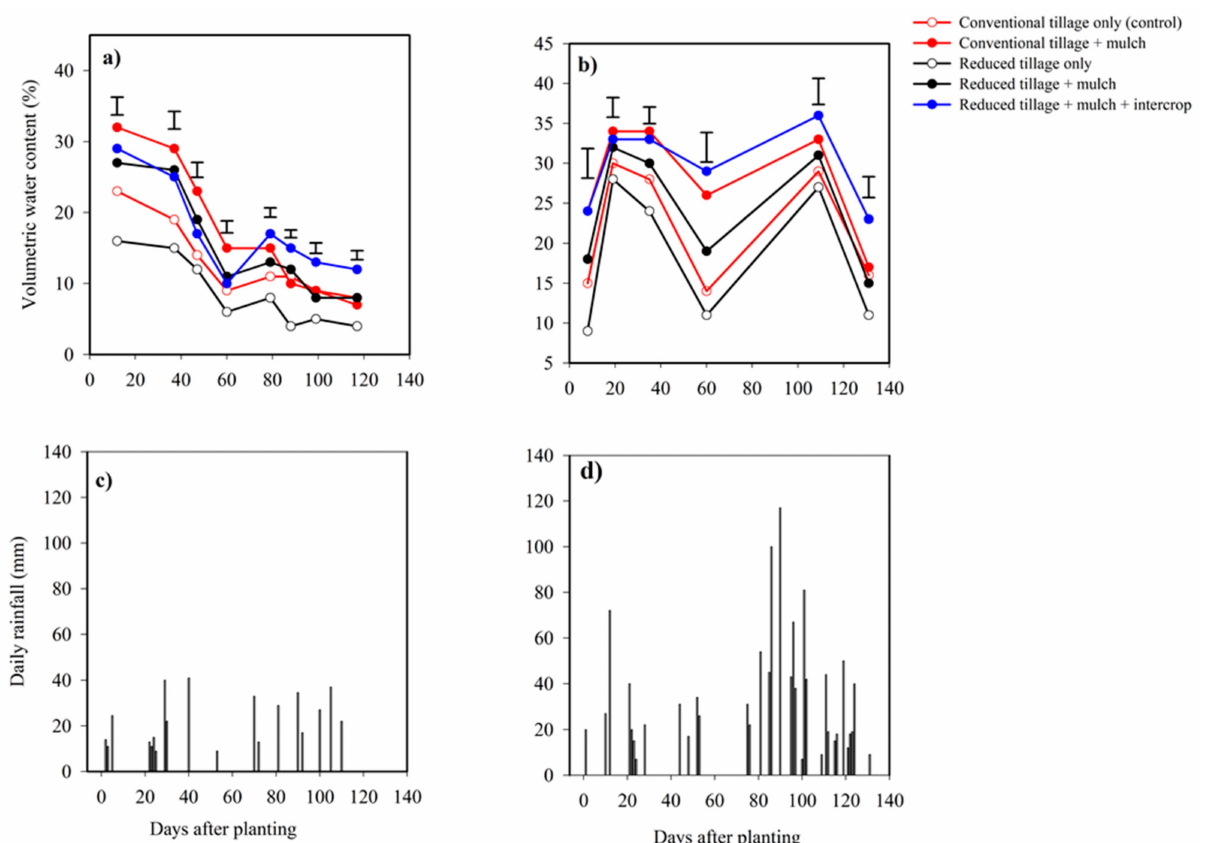
Figure 2. Volumetric water content (0–45 cm) ( a , b ) and daily in-crop rainfall ( c , d ) under conventional tillage (control), conventional tillage + mulch, reduced tillage only, reduced tillage + mulch and reduced tillage + mulch + intercropping with cowpea treatments in 2015/16 and 2016/17. Error bars represent LSD 0.05